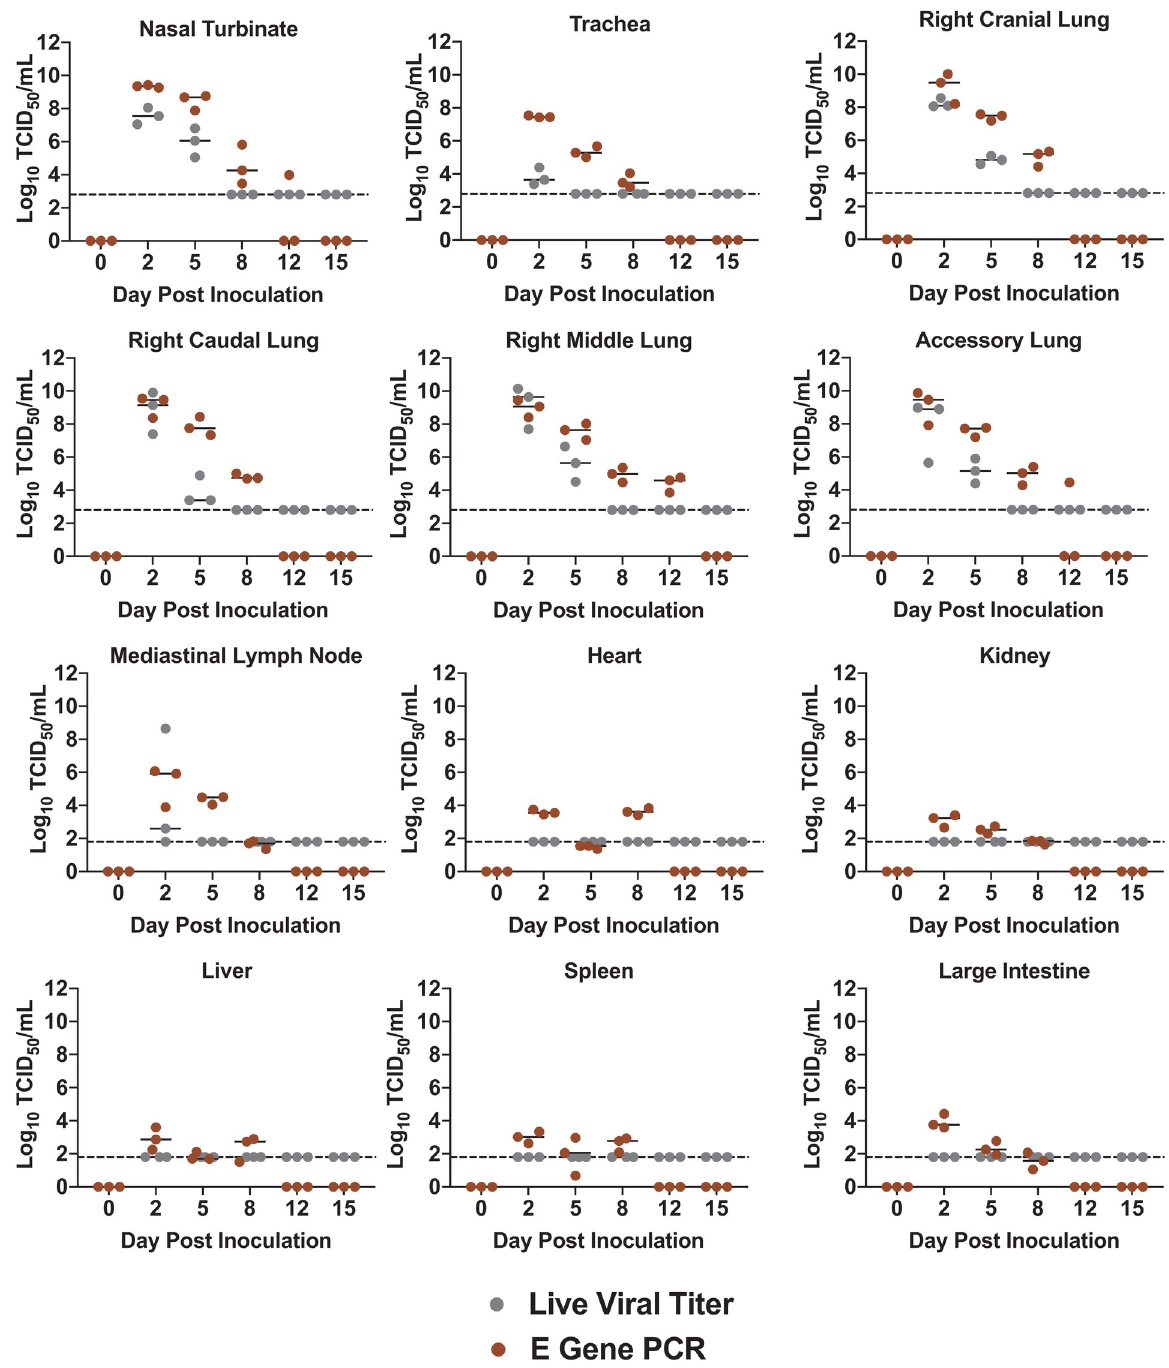
Fig 2. Live SARS-CoV-2 virus is confined to respiratory tissues and mediastinal lymph node while viral RNA is present in extrapulmonary organs. Animals were removed from the study on day 0 prior to infection as well as days 2, 5 8, 12 and 15 post inoculation. Respiratory tissues collected included the nasal turbinate, trachea, and lung (right cranial lobe, right middle lobe, right caudal lobe, accessory lobe). Extrapulmonary organs analyzed included the mediastinal lymph node, heart, kidney, liver spleen and large intestine. All tissues were harvested to quantify virus by qPCR detection of the SARS-CoV-2 E gene in TCID 50 /mL equivalents based on a standard curve of viral RNA using RNA extracted from a stock of SARS-CoV-2 with a known concentration (TCID 50 /mL) (Brown). The infectious virus was quantified by a Tissue Culture Infectious Dose Assay and expressed in TCID 50 /mL (Grey). TCID 50 /mL was calculated using the Reed and Muench method. The dotted line represents the limit of detection in the live viral load assay, based on the lowest dilution of sample. The limit of detection for qPCR detection of the E gene was 10 1 TCID 50 /mL. Data points represent individual animals and line represents the average.